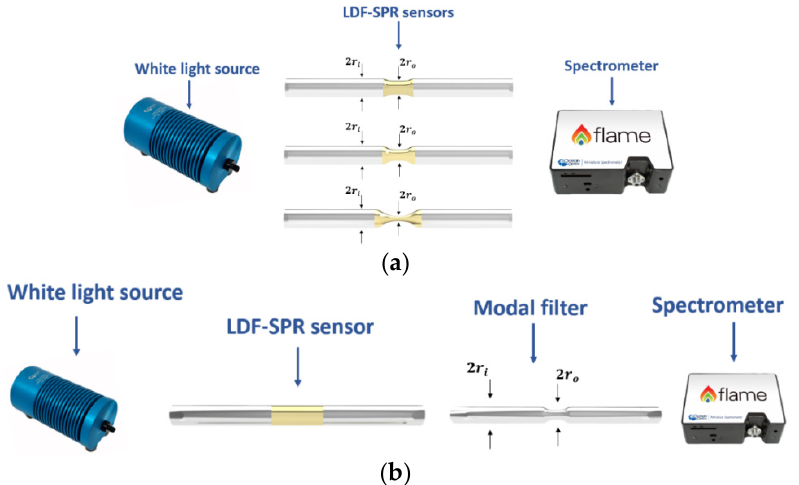
Figure 1. ( a ) Experimental tapered LDF-SPR sensors with three different taper ratios: 1.3, 2.3, and 4.6; ( b ) experimental SPR-LDF sensor configuration implementing a tapered LDF as a modal filter.